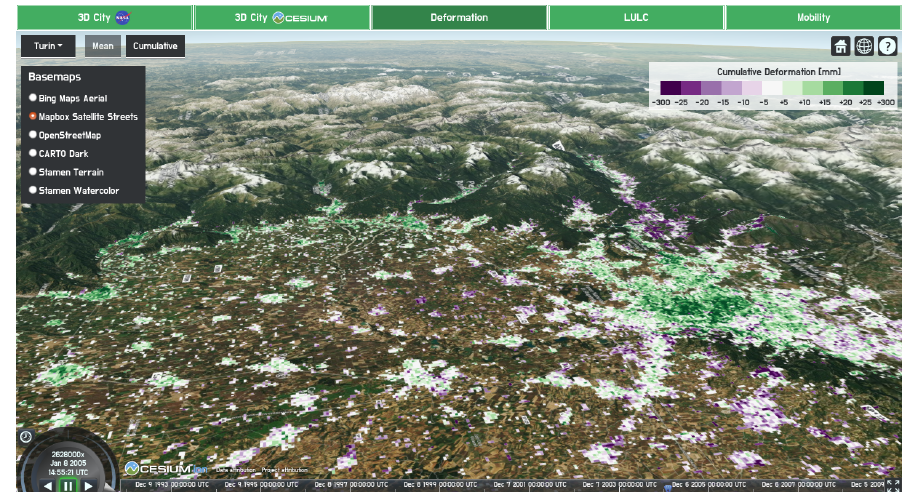
Figure 9. Visualization of the raster file of 2005 from the raster deformation time series of Turin on a virtual globe created using